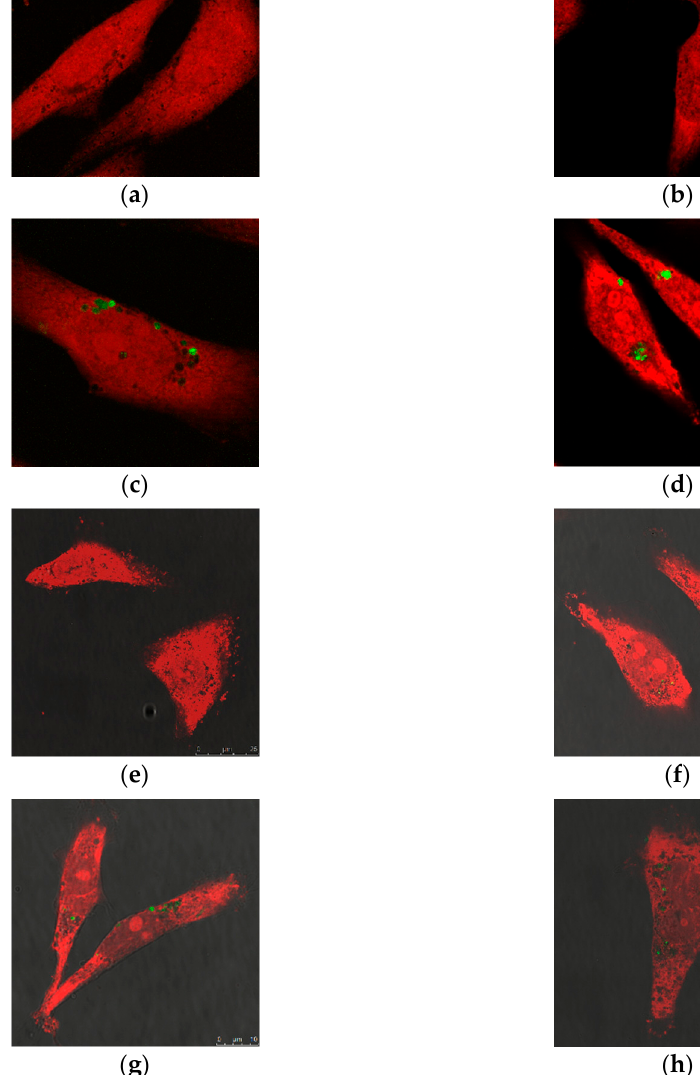
Figure 2. Confocal microscopy images showing endocytosis of S-MSN@PDA (FITC-labelled; green), and R-MSN@PDA (FITC-labelled; green), respectively. ( a , e ) control (no particles); ( b , f ) 5 µ g / mL; ( c , g ) 10 µ g / mL; and, ( d , h ) 25 µ g / mL, respectively. The images were taken using 63X oil objective lens after 24 h incubation with MDA-MB-231 cells (PI-stained; red). Scale bar = 25 µ m for all images.